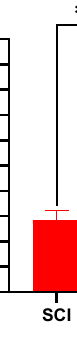
Figure 1. Beneficial protective effect of EMF stimulation after complete SCI on locomotion. The representative BBB score data were compared between SCI ( n = 12) and EMF ( n = 14) groups of rats at week 8. *** p < 0.001 indicates a comparison between SCI and SCI-treated EMF groups.